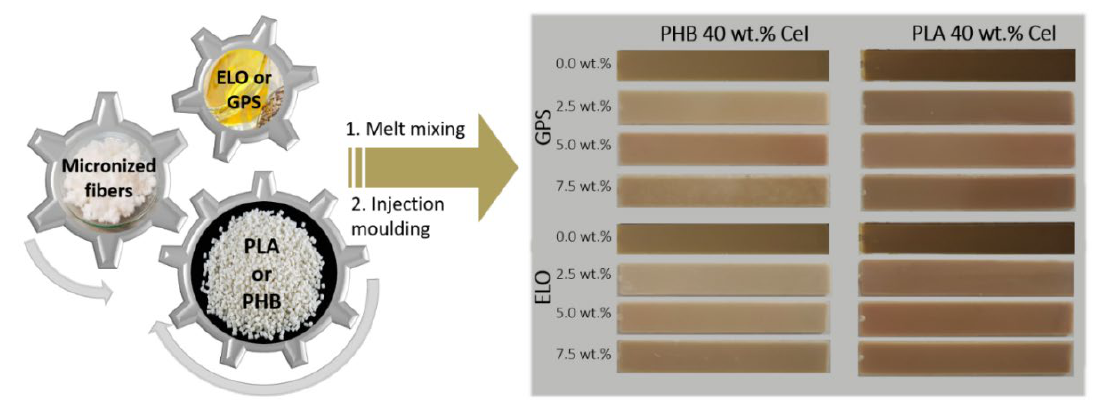
Figure 1. Schematic illustration of the experimental procedure and photographs of the injection- molded specimens of poly(hydroxybutyrate) (PHB) and poly(lactic acid) (PLA)-based composites reinforced with cellulose micronized fibers with different percentages of GPS and ELO